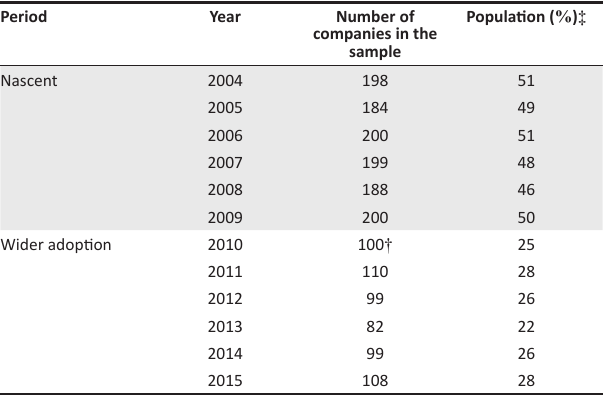
TABLE 4: Number of companies included in the